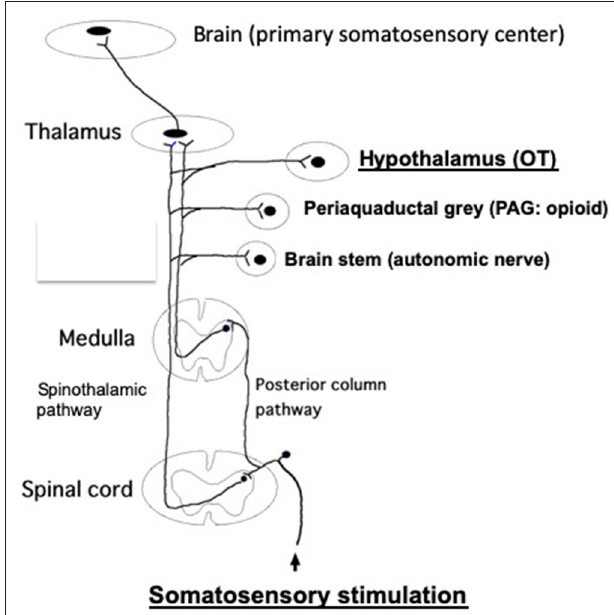
FIGURE 2 | The posterior column pathway and spinothalamic pathway, which are responsible for the spinal–supraspinal pathways following somatosensory stimulation. These impulses are sent to the primary somatosensory cortex, through the thalamus. In addition, these impulses are relayed to other brain areas (brain stem, PAG, hypothalamus, etc.) via the collateral connections. Somatosensory stimulations, such as TENS, acupuncture, massage and skin touch, etc., promote antistress effects via stimulating somatosensory pathway, finally activating OT system at the hypothalamus. It has been shown that both somatic myelinated/unmyelinated afferent fibers mediate sympathetic nerve activities (Isa et al., 1985). Further studies are needed whether afferent myelinated and/or unmyelinated fibers are involved to mediate OT release from the brain. It remains unknown which afferent fibers are involved in the posterior column pathway and spinothalamic